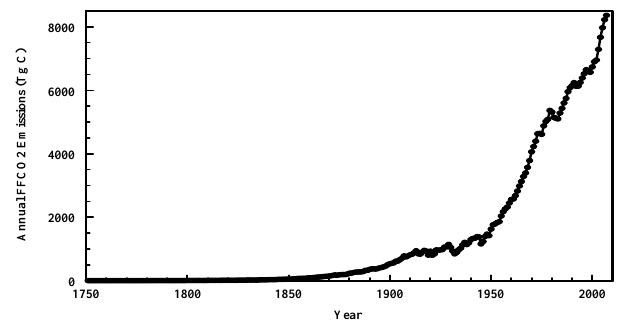
Fig. 3b. Growth of FFCO2 emissions from the year 1752 to 2007. Positive values indicate an increase in year-to-year emissions and negative values indicate a decrease in year-to-year emissions. A gray zero line has been added for reference. Data from Boden et al. (2010).